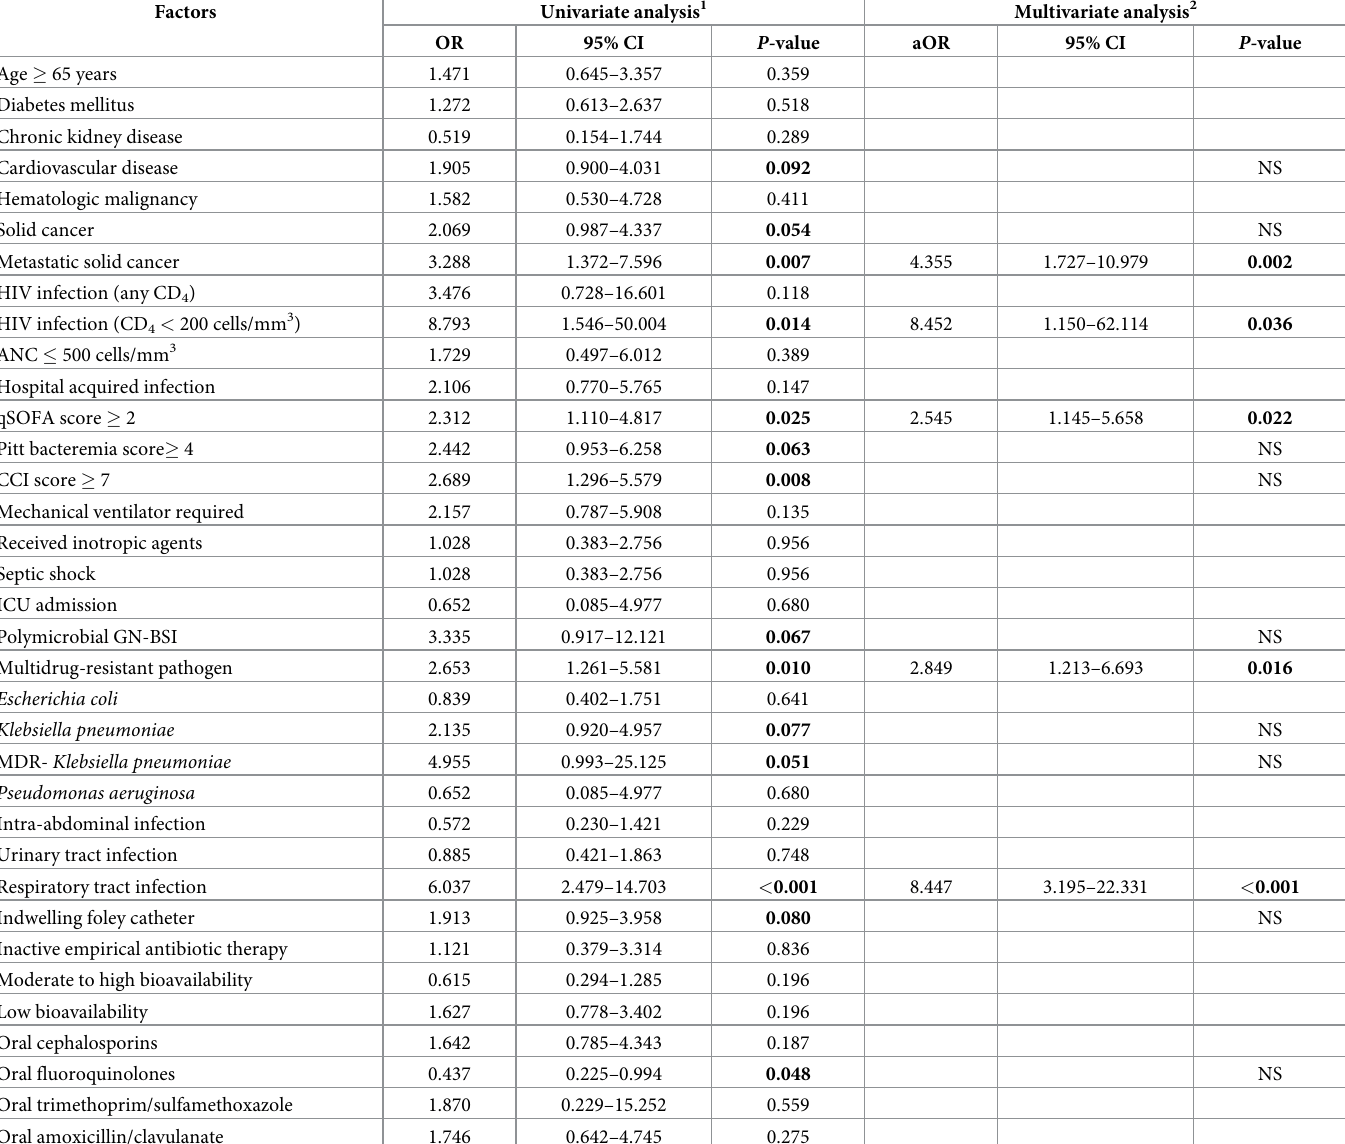
Table 4. Factors associated with treatment failure in hospitalized patients with Gram-negative bloodstream infection in intravenous to the oral antibiotic agent transition group (n = 545).